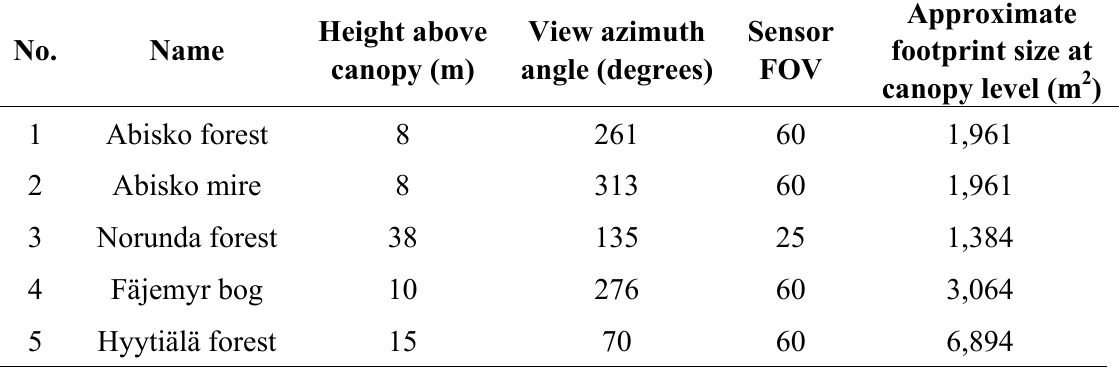
Table 3. Geometry information multispectral measurements or reflected radiation.